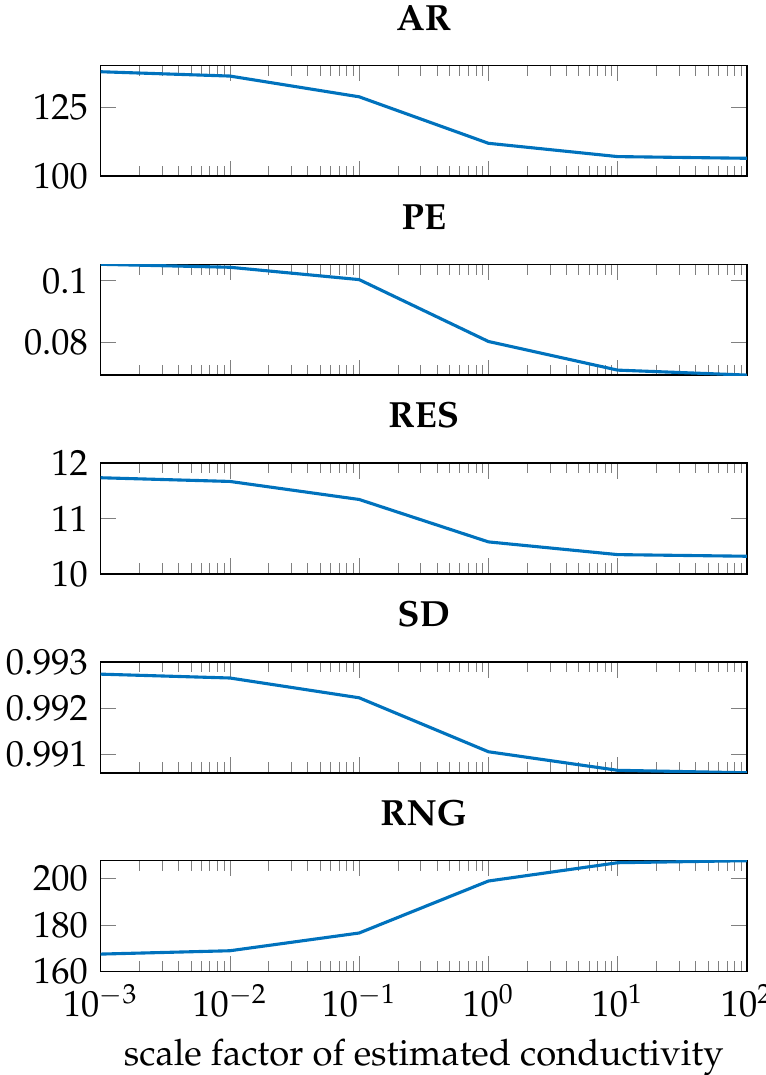
Figure 14. GREIT figures of merit for the combination of EIT and radar data, for R 1 = 3 without noise and R 2 = 4. The radar estimation conductivity was changed and scaled